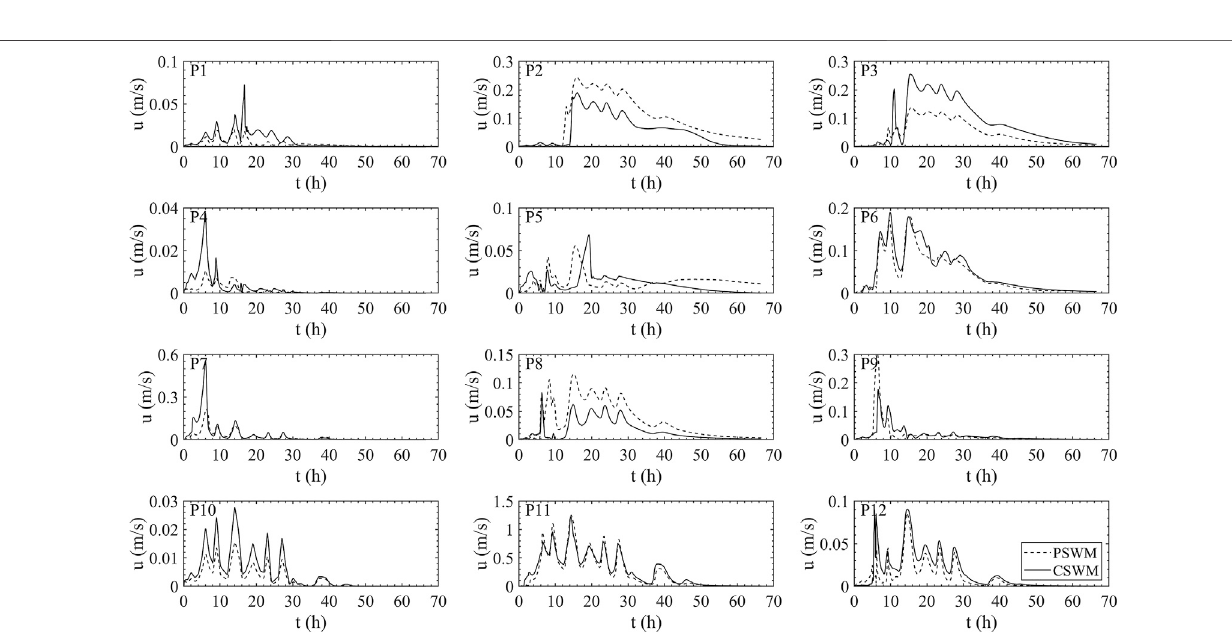
Frontiers in Earth Science |